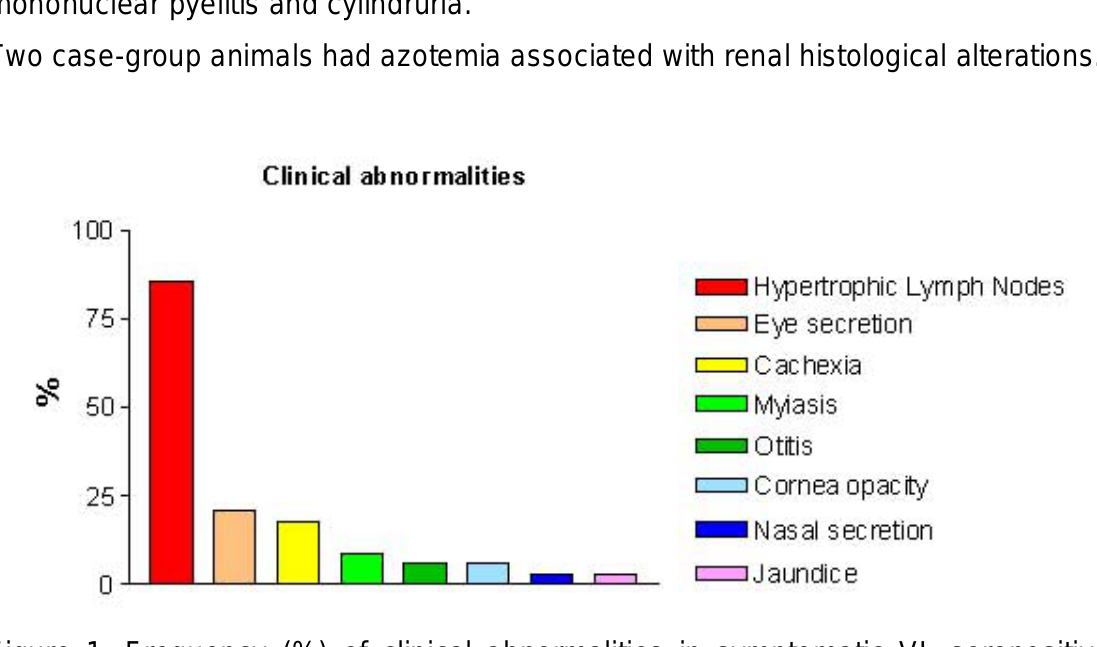
Figure 1: Frequency (%) of clinical abnormalities in symptomatic VL seropositive dogs (n=34) from Teresina, Piauí State, Brazil,